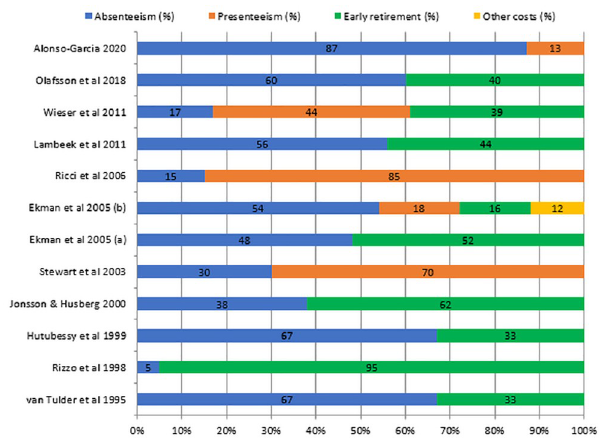
Fig 3. Allocation of indirect costs in COI studies of back pain. Legend: The figure illustrates the allocation of indirect costs in studies that reported on at least two of the three major costs components (absenteeism, presenteeism, and early retirement costs) of indirect